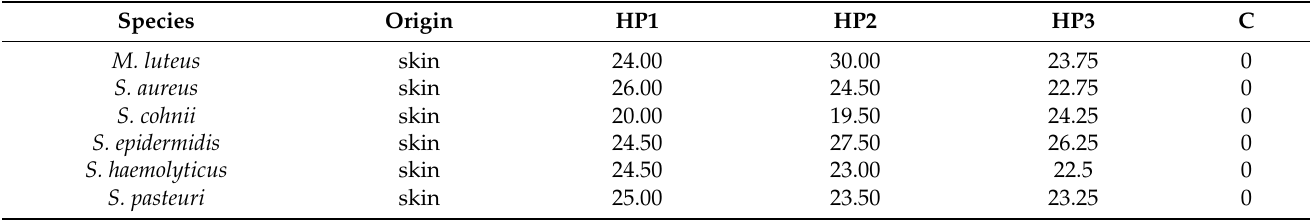
Table 1. Growth inhibition zones (mm) for bacterial and Candida strains, as a result of application of films containing three propolis